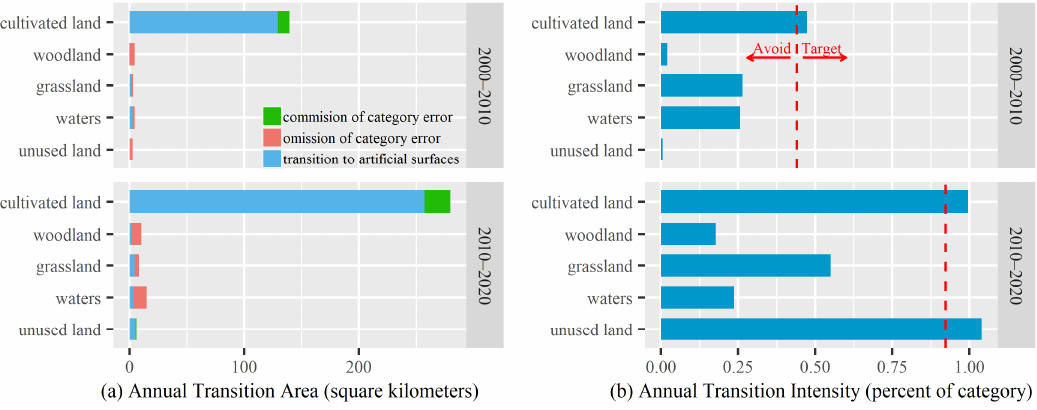
Figure 15. Intensity analysis for transition to artificial surfaces for the lower reaches. The transition size along with hypothetical map errors ( a ); transition intensities ( b ). The red, vertical dashed lines indicate the uniform intensities.